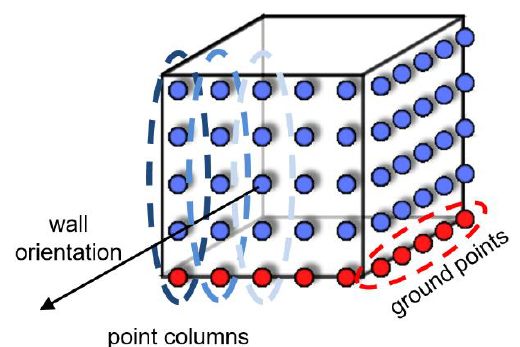
Figure 2: Observer points organized in ground points with z=0 and associated point columns. Corresponding wall orientation is stored together with the point